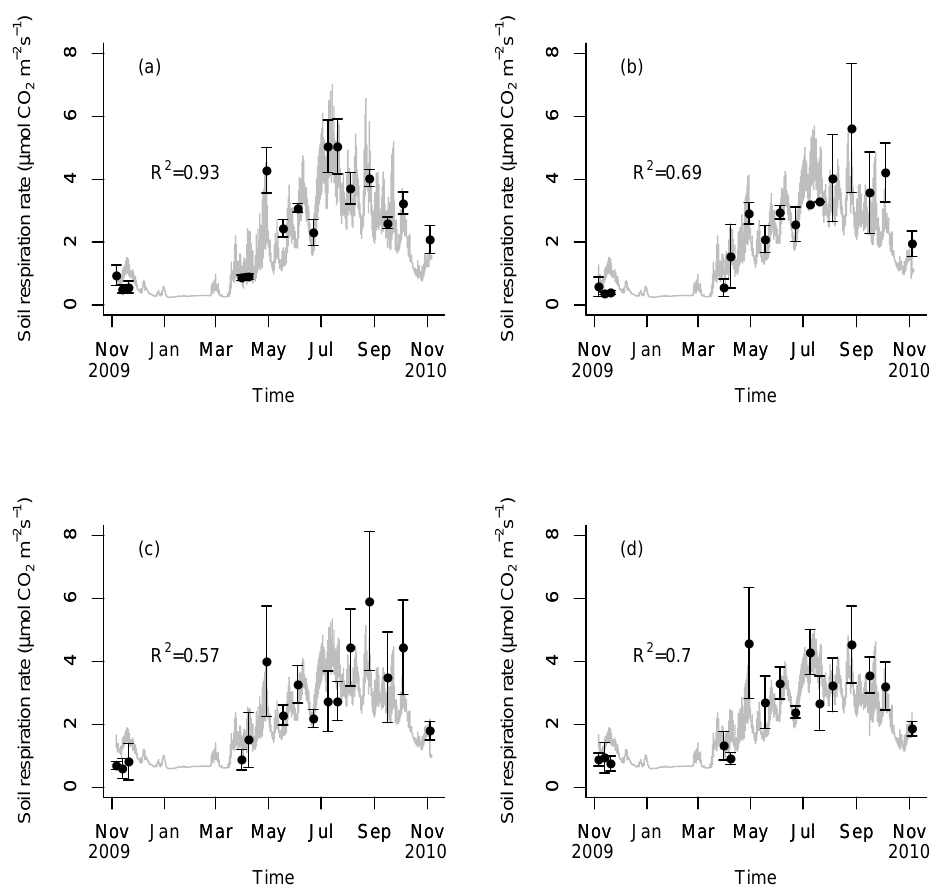
Figure 1. Measured (full symbols) versus modelled (continuous line) soil respiration rate (in µmol CO 2 m − 2 s − 1 ), for PyOM under ambient Figure 1 N (a) , PyOM under increased N (b) , wood under ambient N (c) and wood under increased N (d) . Error bars represent the standard error of the mean ( n = 3) of the measured soil